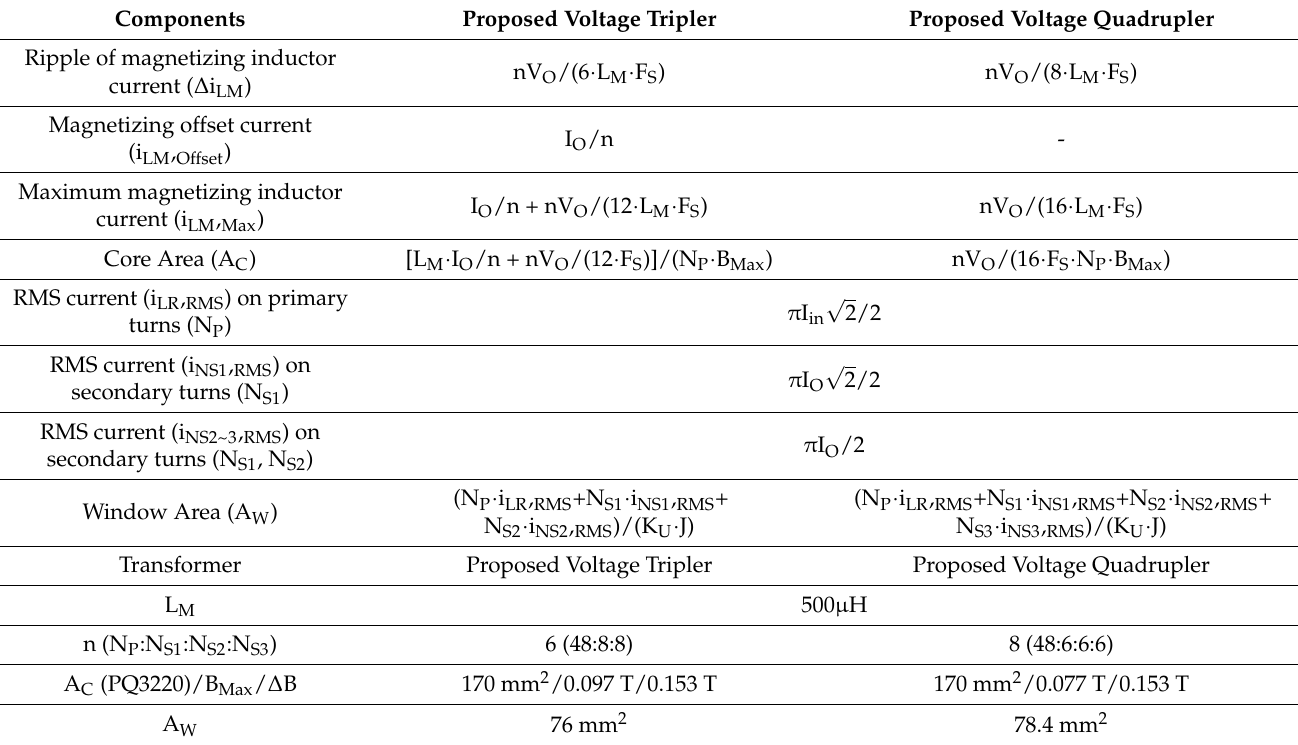
Table 4. Design parameters for transformer and resonant inductor (L R